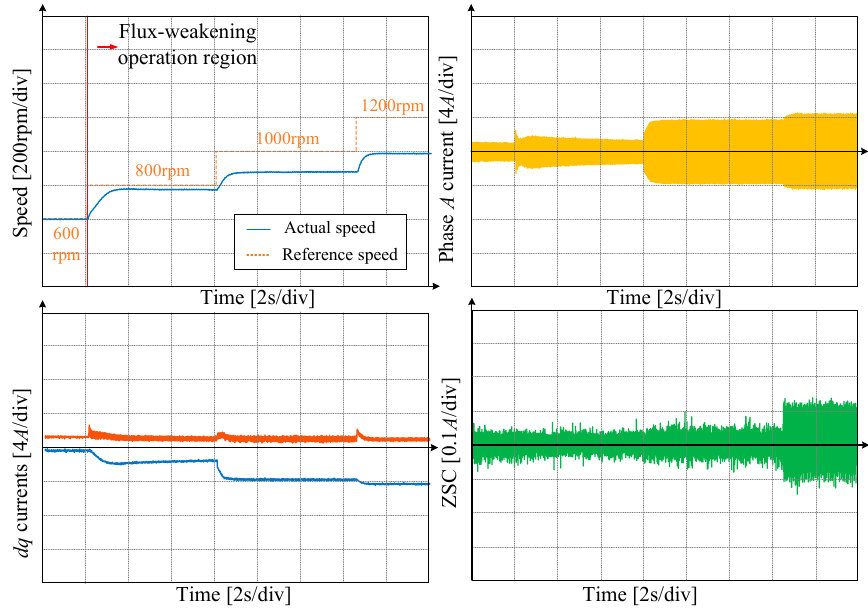
Figure 23. Dynamic performance of conventional controller under 0.6 Nm.